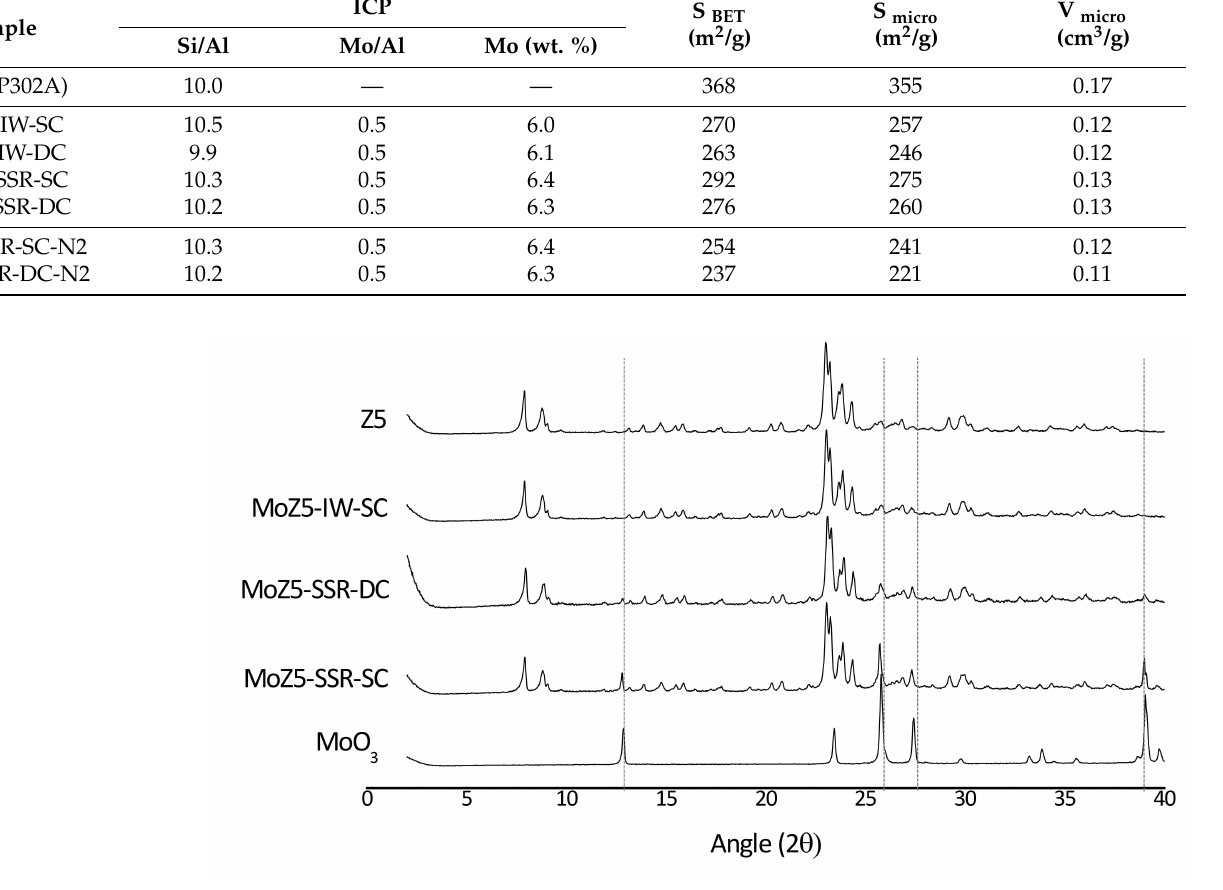
Figure 1. PXRD patterns of the Mo/ZSM-5 catalysts. The most characteristic peaks related to the presence of MoO 3 are marked with a dotted